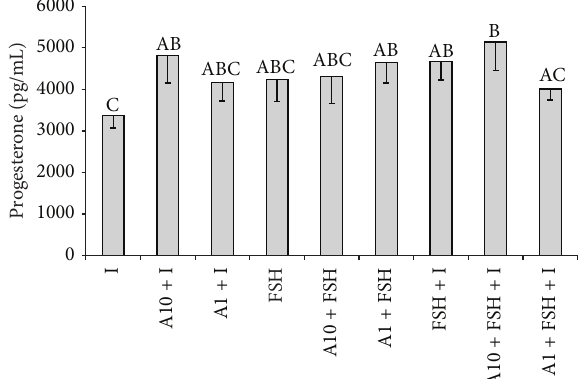
Figure 3: The effect of adiponectin (10 𝜇 g/mL-A10 and 1 𝜇 g/mL- A1) on insulin-stimulated (I; 10ng/mL) and/or FSH-stimulated (10ng/mL) progesterone secretion by cultured granulosa cells col- lected on days 17–19 of the oestrous cycle. Bars with different superscripts are significantly different ( 𝑃 < 0.05 ). Results are means